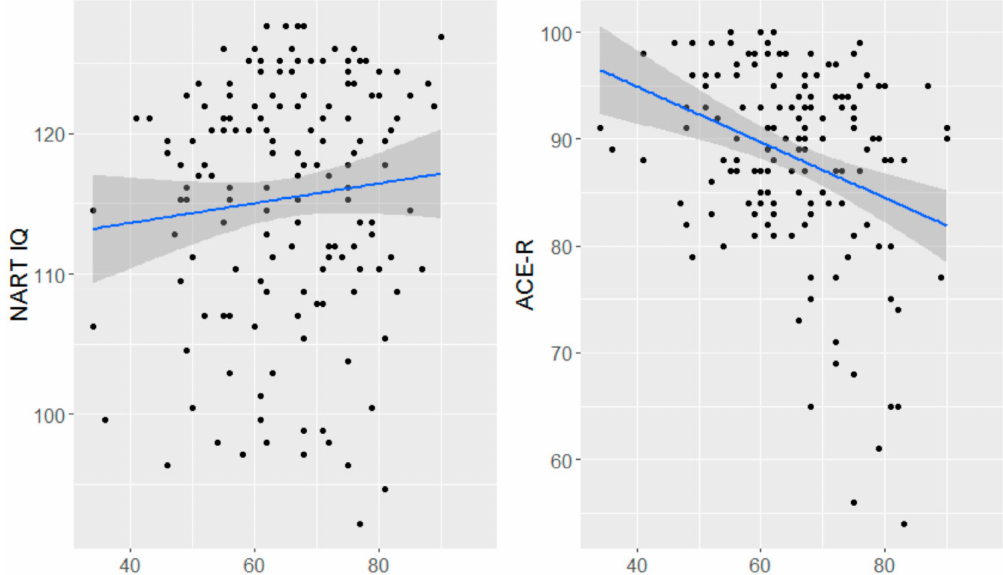
Figure 3. The relationship between NART IQ and ACE-R with age at first assessment at between one to three